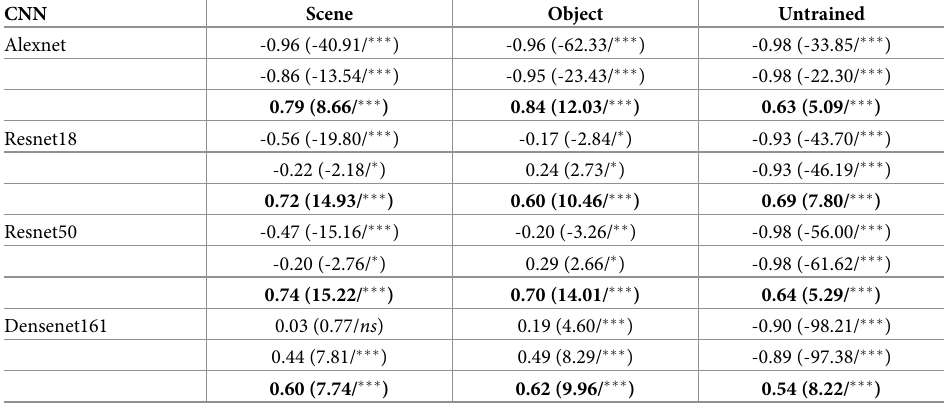
Each of the untrained CNNs was the average of 100 random weight initialized CNNs. The first two rows of each CNN are Euclidean distance measures of “Same Object/Different Configuration” and “Different Object/Same Configuration” respectively. The bolded third row of each CNN are the index measures. Coefficients ( r ) were calculated separately for each image set and then averaged over all the image sets in a collection. The coefficients were tested at the group level against zero using two-tailed t tests and the resulting t and p values are reported in parentheses. Results include the r value, the t-value, and p-value in [r/(t/p)] format. ��� p < .001 �� p <